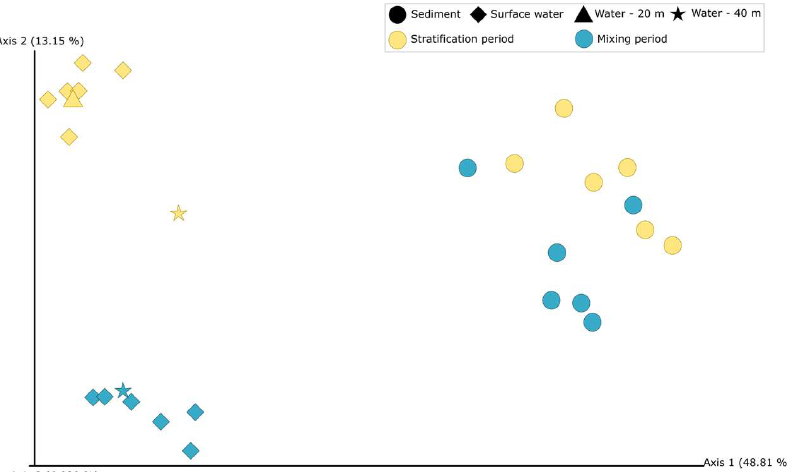
Figure 3. Two-dimensional plot of a three-dimensional principal component analysis based on the beta diversity of bacterial communities (calculated using Bray–Curtis, colors indicate the sampling periods, shapes indicate the sample types).